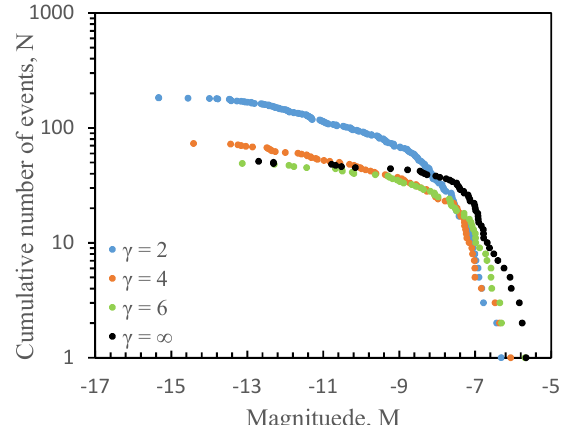
Fig. 5. Acoustic Event moment magnitude distribution for various Weibull shape parameter,